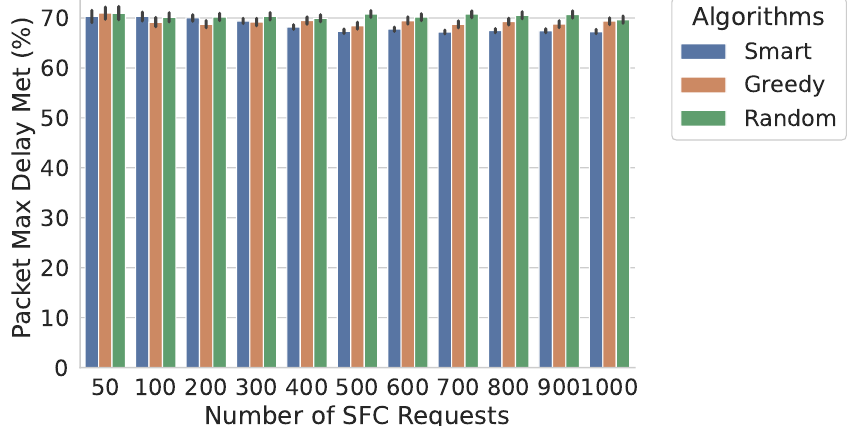
Figure 11. Percentage of packets that do not exceed the maximum tolerable